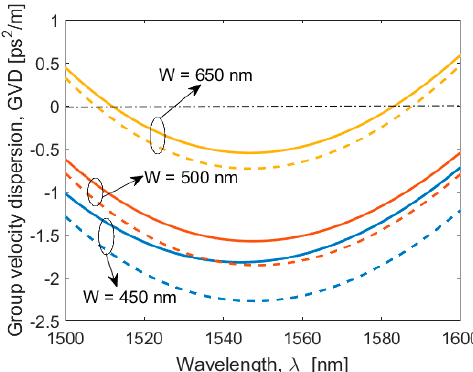
Figure 2. Group Velocity Dispersion (GVD) coefficient spectrum for different values of the SOI waveguide width, assuming 𝐻 = 220 nm (solid line) and 𝐻 = 250 nm (dashed line).